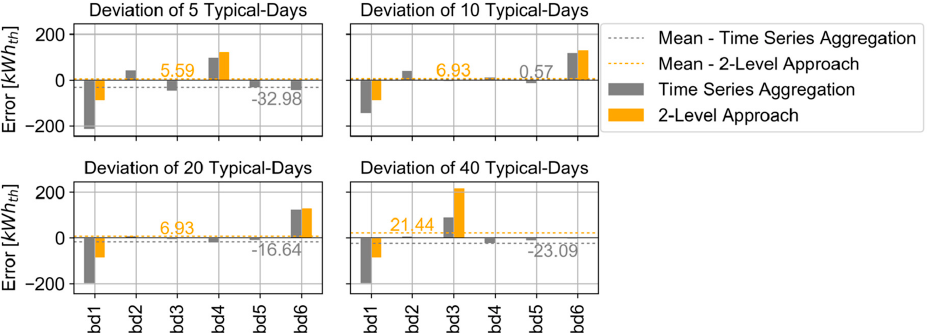
Figure 8. Figure 8. Deviation of installed heat storage capacities with the 2-Level Approach and time series aggregation.